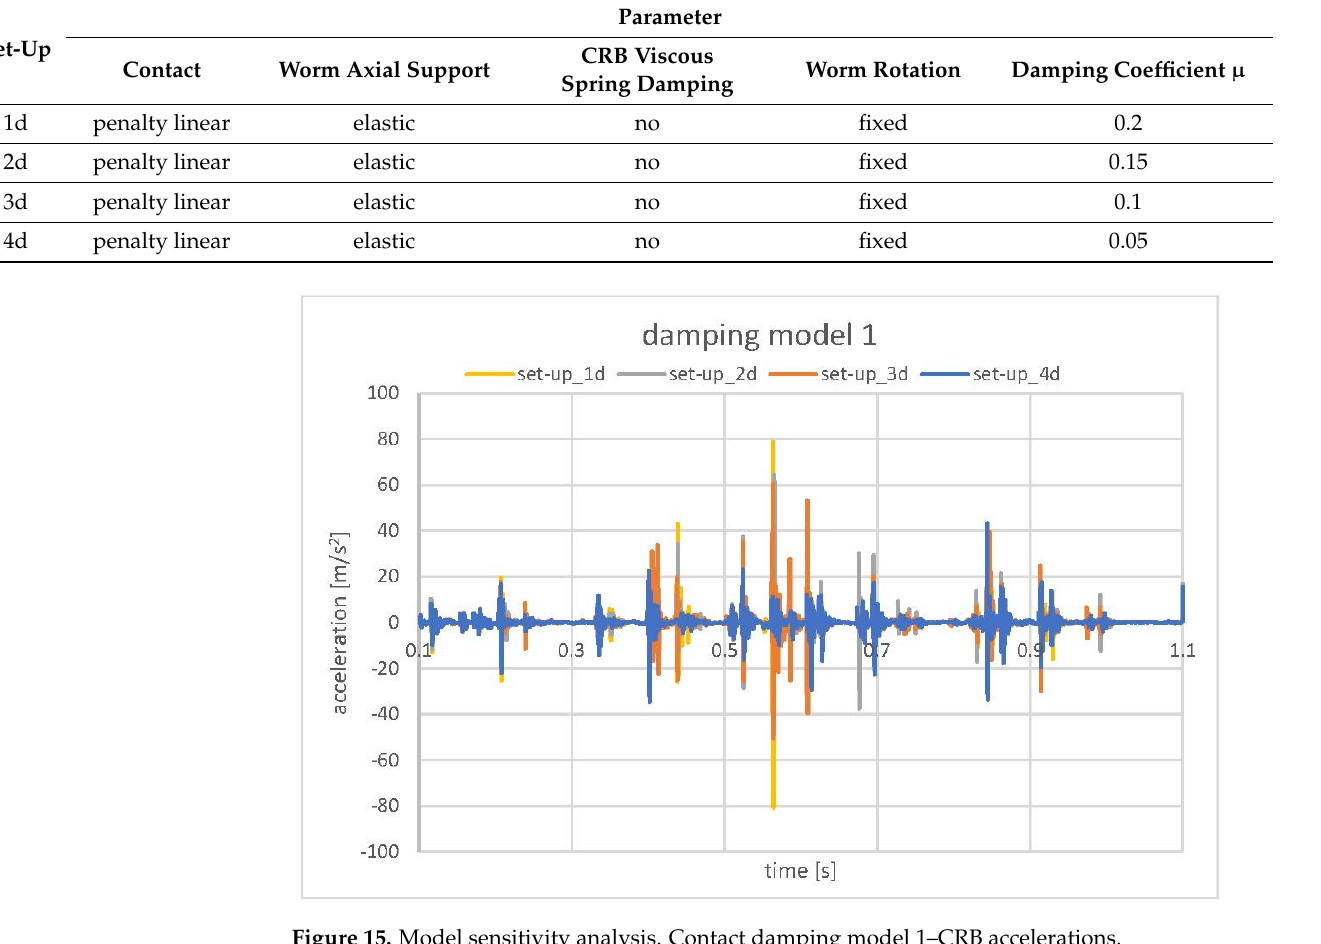
Figure 15. Model sensitivity analysis. Contact damping model 1–CRB accelerations.